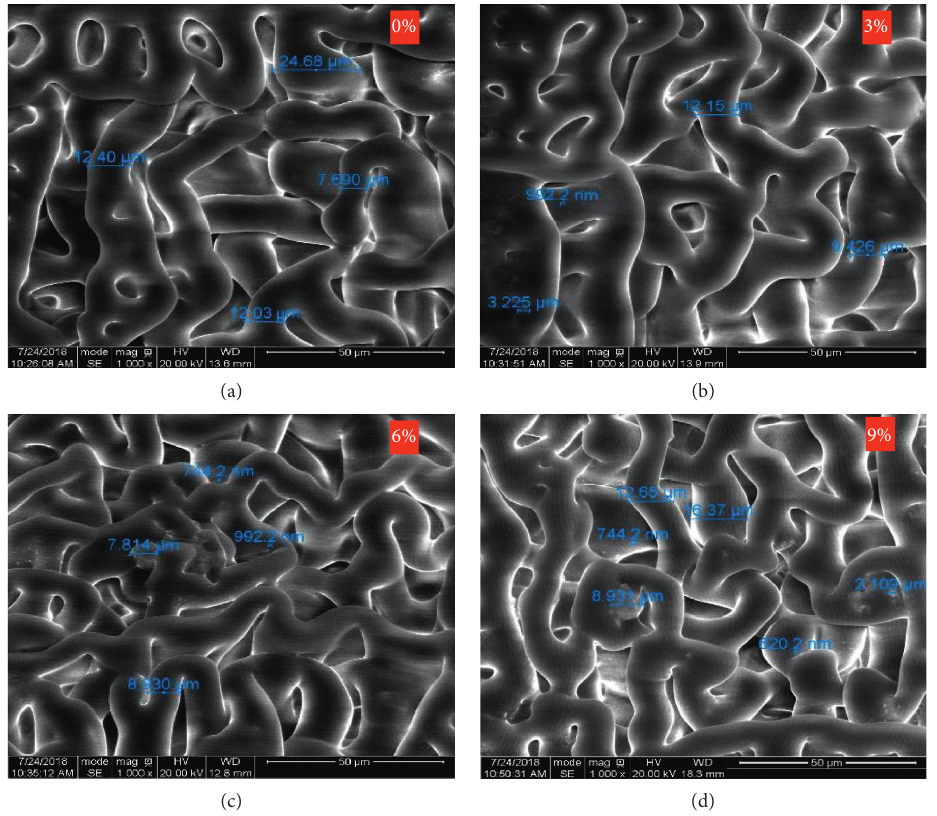
Figure 11: ESEM observation of different percentage of